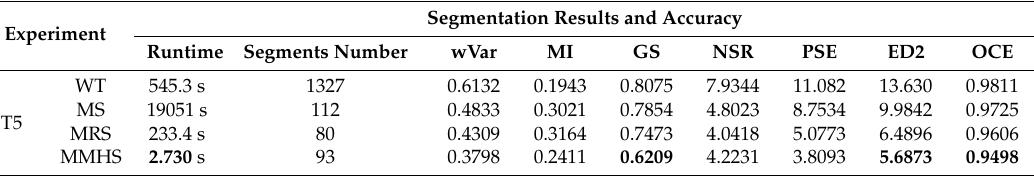
Table 9. The quantitative assessment results of the Potsdam aerial image (T5). Experiment